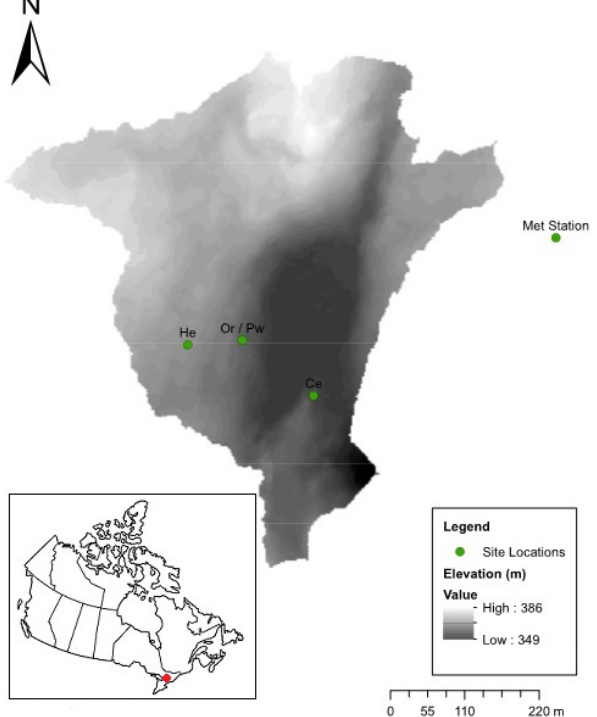
Figure 1. Digital elevation model of the PC-1 catchment, showing the location of trees sampled for xylem water and bulk soil water (Ce – eastern white cedar, He – eastern hemlock, Or – red oak, Pw – eastern white pine) and the meteorological station.